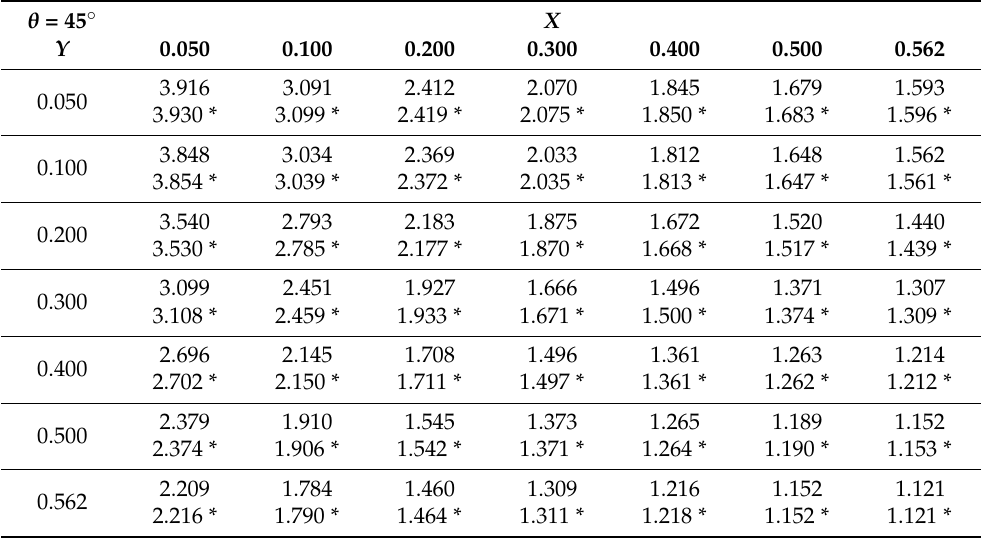
Table 3. Comparison of K tb values calculated using Equation (A2) (*) to the corresponding FEM results for various X and Y , while T / a = 1 and θ = 45°.